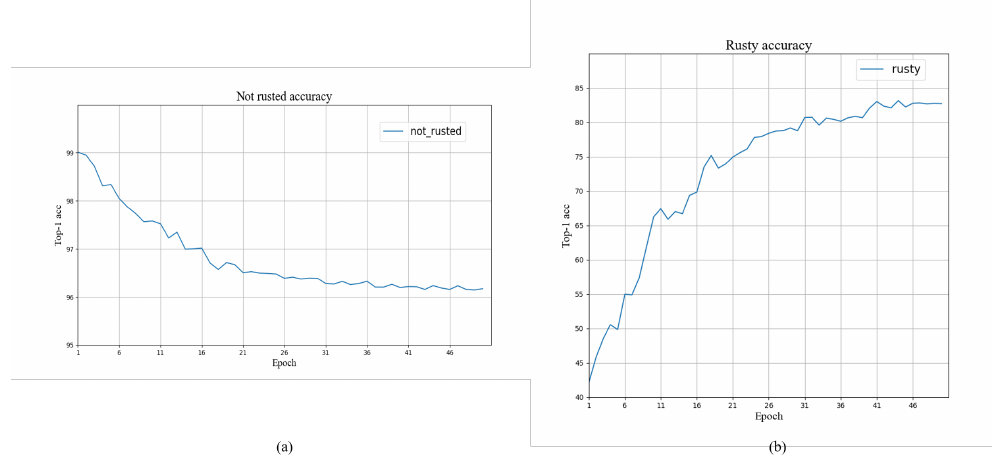
Figure 6. ( a ) Figure shows the accuracy of the unrusted (Many) category; ( b ) Figure shows the accuracy of the rusty (Few) category.